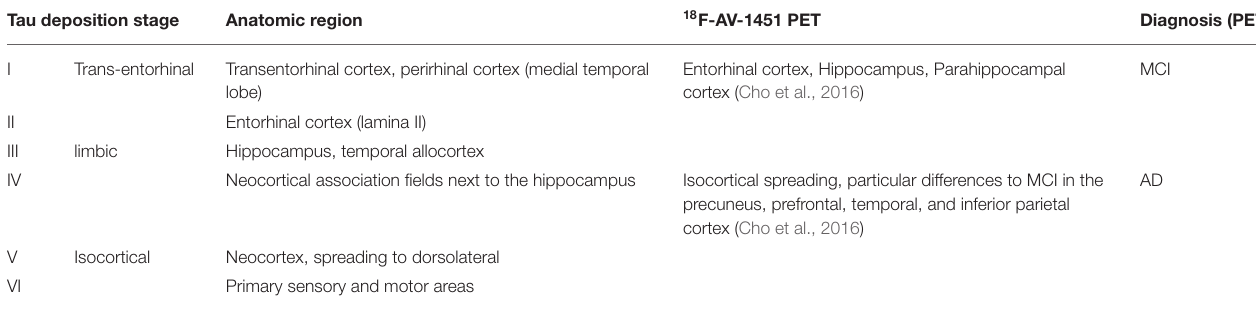
TABLE 4 | Braak stages of Tau deposition (Braak and Braak, 1991, 1997; Taylor and Probst,